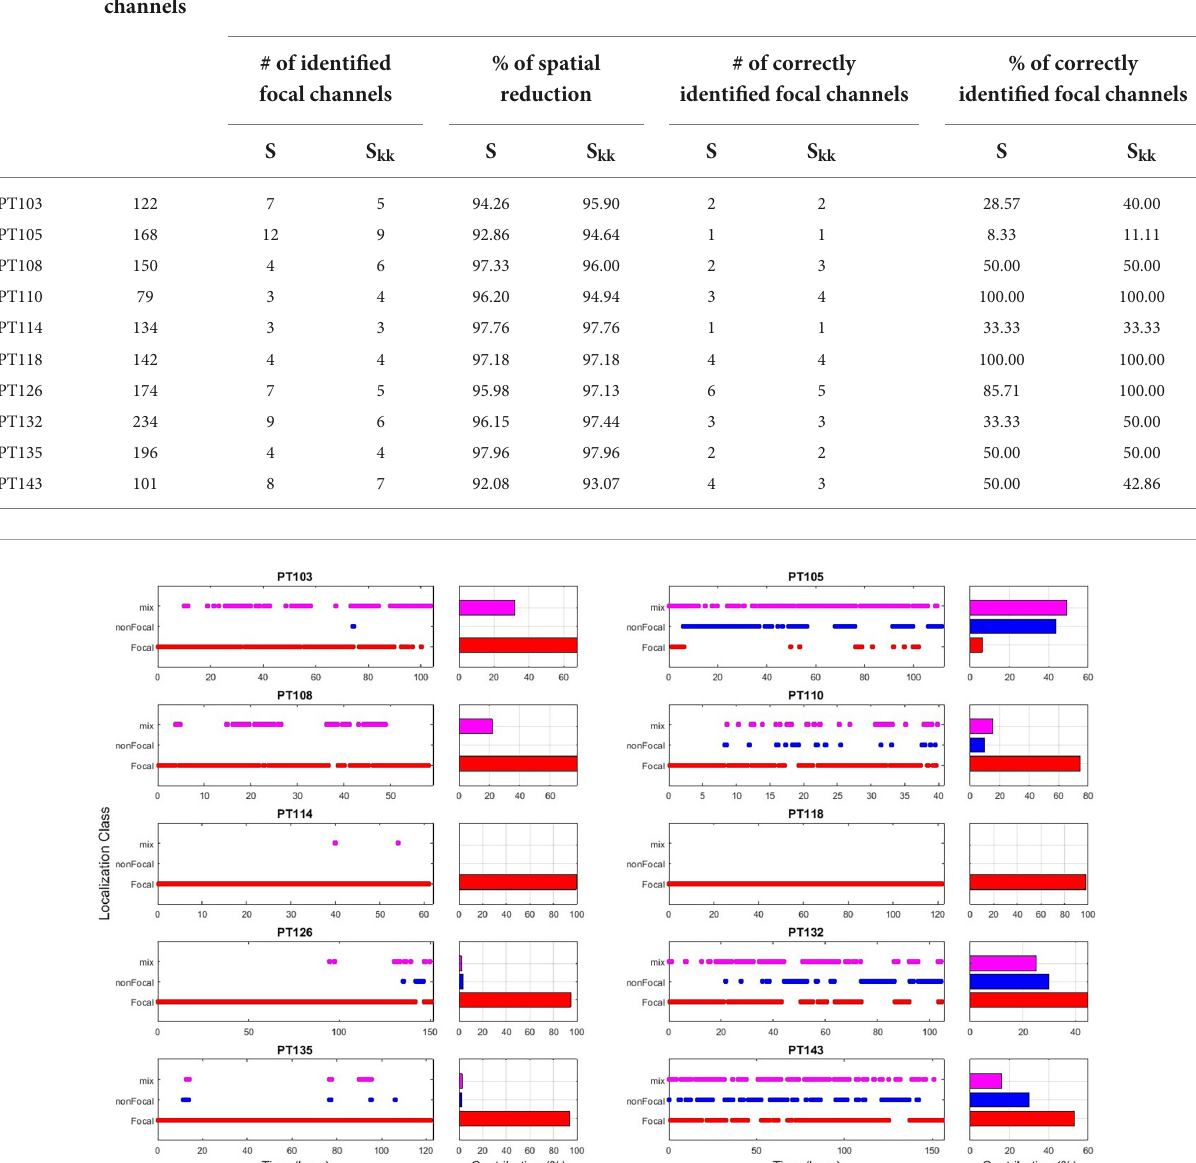
TABLE 2 Performance metrics of spatial reduction and EZ localization using S and S kk . Patient